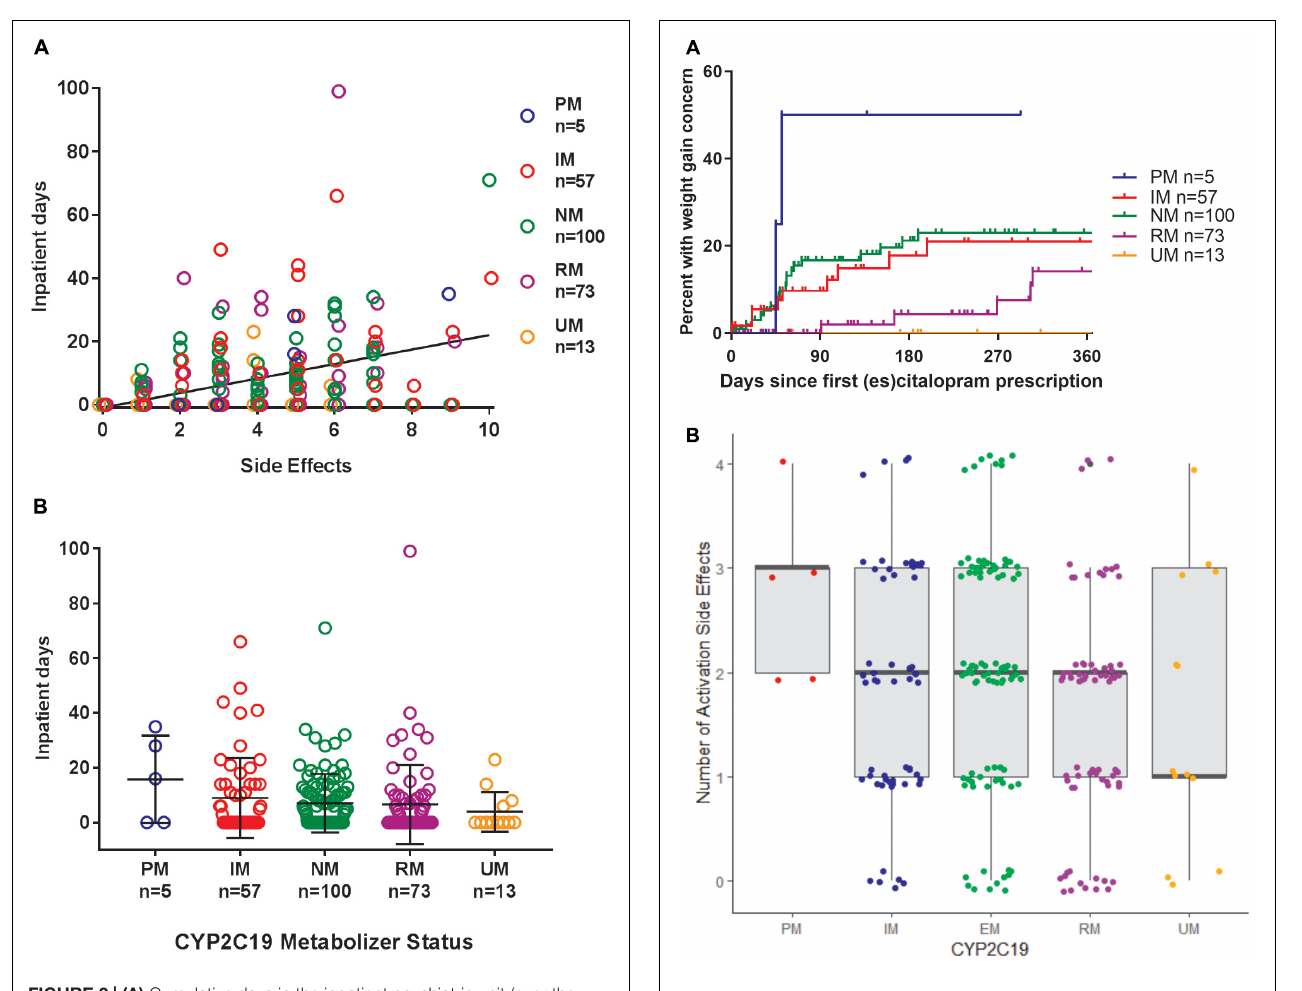
FIGURE 3 | (A) Time to first weight gain concern during es/citalopram treatment is associated with CYP2C19 metabolizer status ( p = 0.018, log-rank test for trend). B , Number of activation side effects during es/citalopram treatment is associated with CYP2C19 metabolizer status ( p = 0.029, one-way ANOVA with test for trend). Median and interquartile range are indicated by the bar and whiskers. PM, poor metabolizer; IM, TABLE 6 | Multivariate model of weight